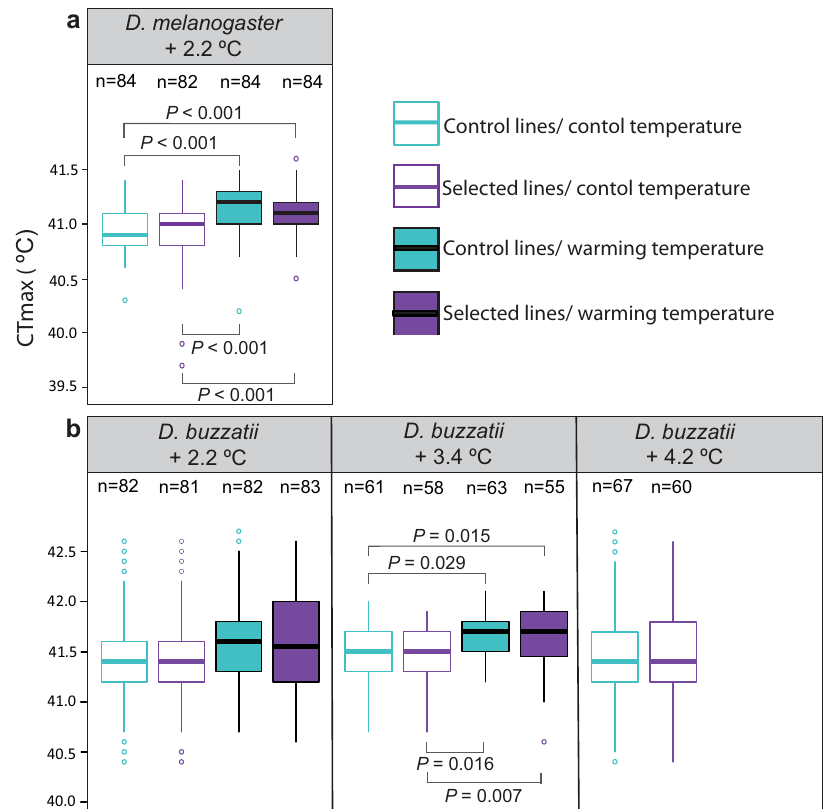
Fig. 5 The response of critical thermal maxima (CTmax) to gradual experimental warming in two species of Drosophila . Knockdown CTmax (boxplots denoting the median (solid horizontal lines), upper and lower quartiles (boxes), 1.5× interquartile range (vertical lines) and outliers (circles)) across four replicate control (aqua) and four replicate selected (purple) lines of a widespread D. melanogaster after 2.2 °C of warming, and b widespread D. buzzatii after 2.2, 3.4 and 4.2 °C of warming. CTmax was estimated by reciprocally transplanting control and selected lines to developmental temperatures re fl ecting both the control thermal regime (26 ± 3 °C, open bars) and the warming thermal regime (solid bars) at the generation of testing (e.g., 28.2 ± 3 °C after 2.2 °C of warming). Signi fi cant differences (two-sided Tukey post hoc test) between selection lines/developmental temperature within a generation of warming are shown. n = total number of individuals per temperature/treatment. Source data are provided as a Source Data fi